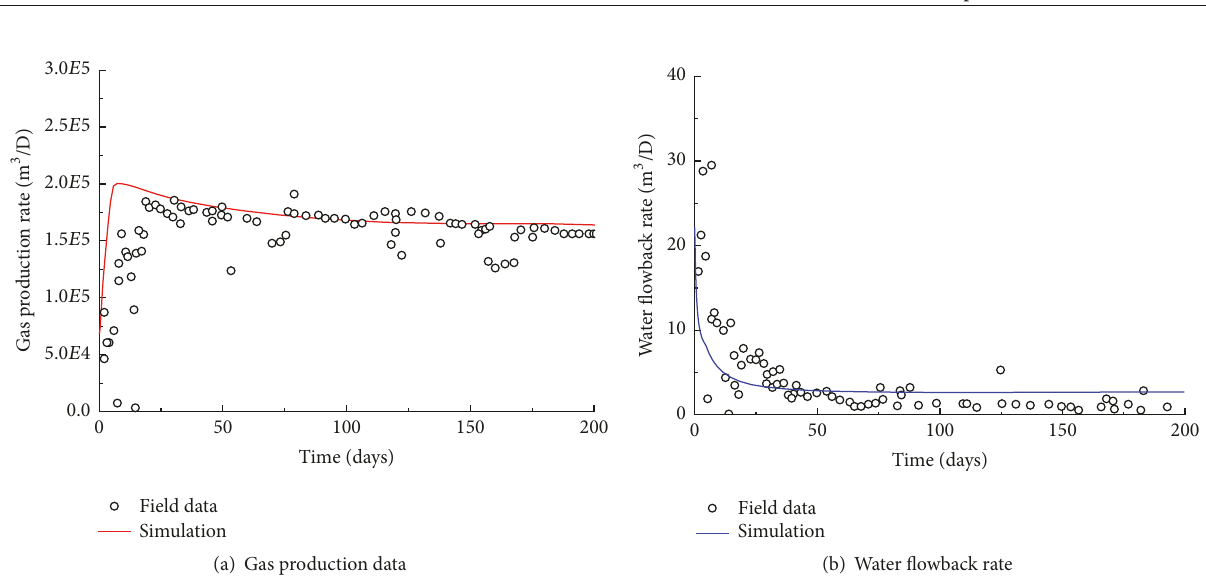
Figure 5: Comparison of numerical simulation with field production data at some China shale gas